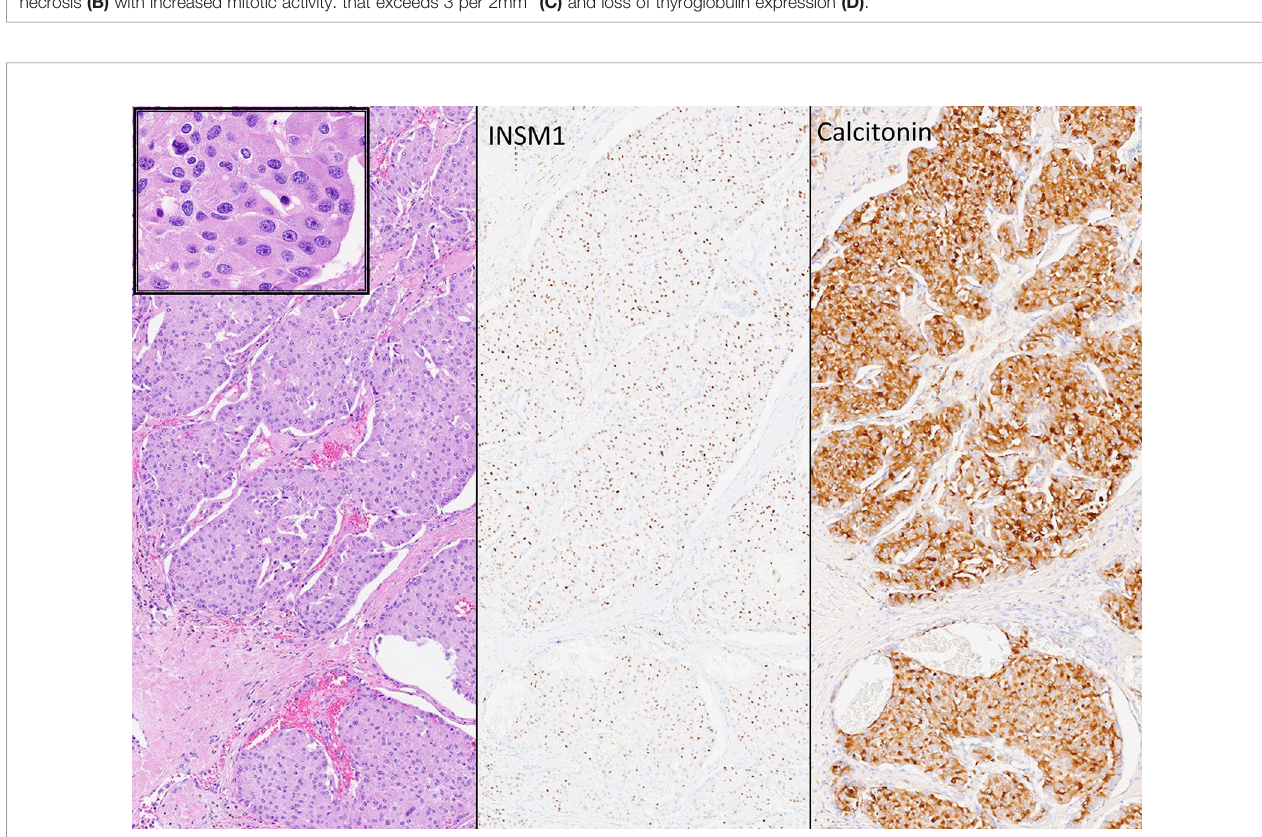
FIGURE 10 | Oncocytic Medullary Thyroid Carcinoma. Medullary thyroid carcinoma can have oncocytic cyology (left and insert). These rare tumors are easily misdiagnosed as oncocytic follicular tumors but immunohistochemistry con fi rms the expression of INSM1 (middle) and calcitonin (right) as well as chromogranin and monoclonal CEA (not shown) that distinguishes these tumors from other calcitonin-expressing neuroendocrine neoplasms.